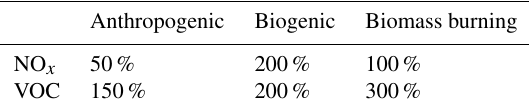
Table 3. The uncertainty assumptions used for estimating the co- variance matrix of the a